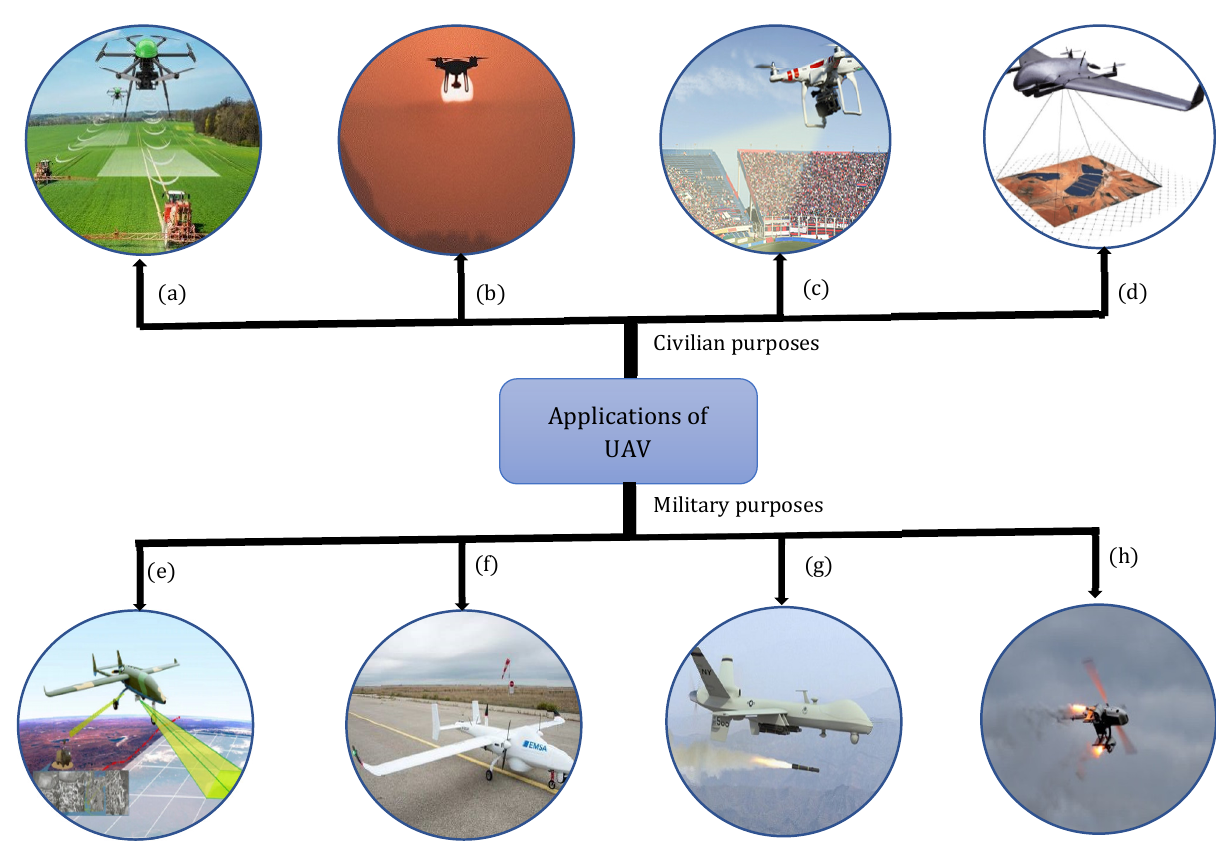
Figure 1. Applications of UAVs in: ( a ) agriculture [11], ( b ) monitoring and data collection (pollution and land monitoring) [12], ( c ) photography (film, video) [13], ( d ) aerial mapping [14], ( e ) reconnais- sance [15], ( f ) surveillance of enemy activity [16], ( g ) attack missions [17], ( h ) decoying missiles by the emission of artificial signatures [18].